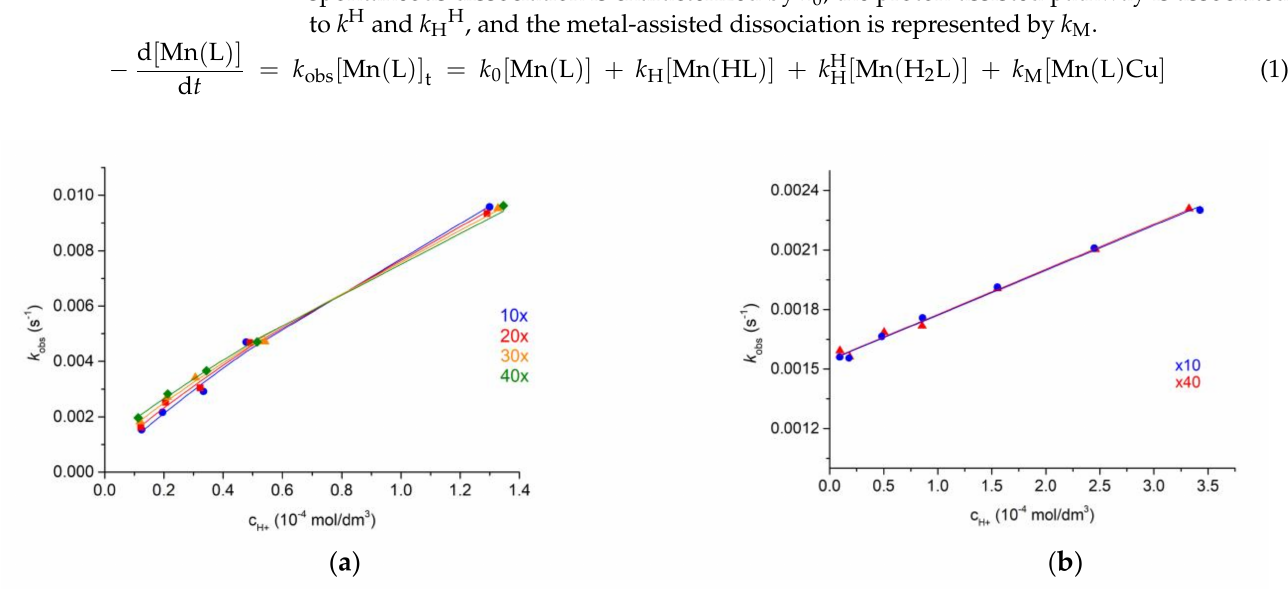
Figure 3. Dissociation rates ( k obs ) of the Mn(II) complexes formed with t O2DO2A 2 − ( a ) or t O2DO2AM Pip ( b ) obtained in the presence of excess Cu(II) and plotted as a function of H + ion concentration ( I = 0.15 M NaCl, T = 25 ◦ C).